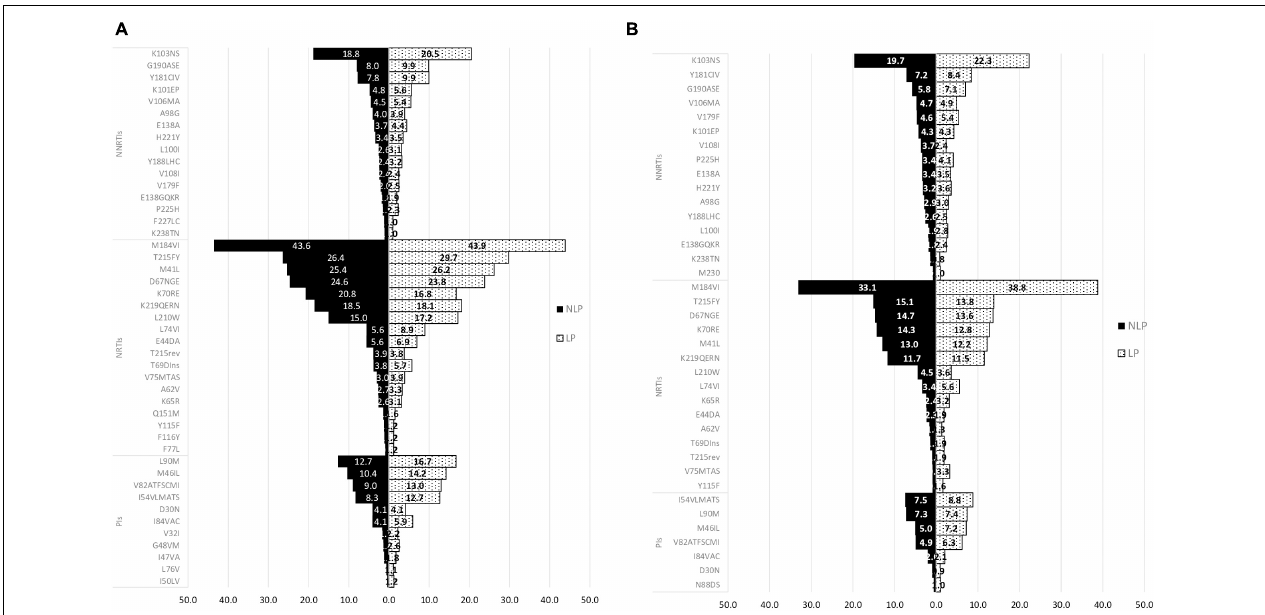
FIGURE 7 | Mutations in Non-Late presenters (NLP) and Late presenters (LP) in subtype B (A) and subtype non-B (B) for ART-experienced patients. PIs, protease inhibitors; NRTIs, nucleoside reverse transcriptase inhibitor; NNRTIs, non-nucleoside reverse transcriptase inhibitor.